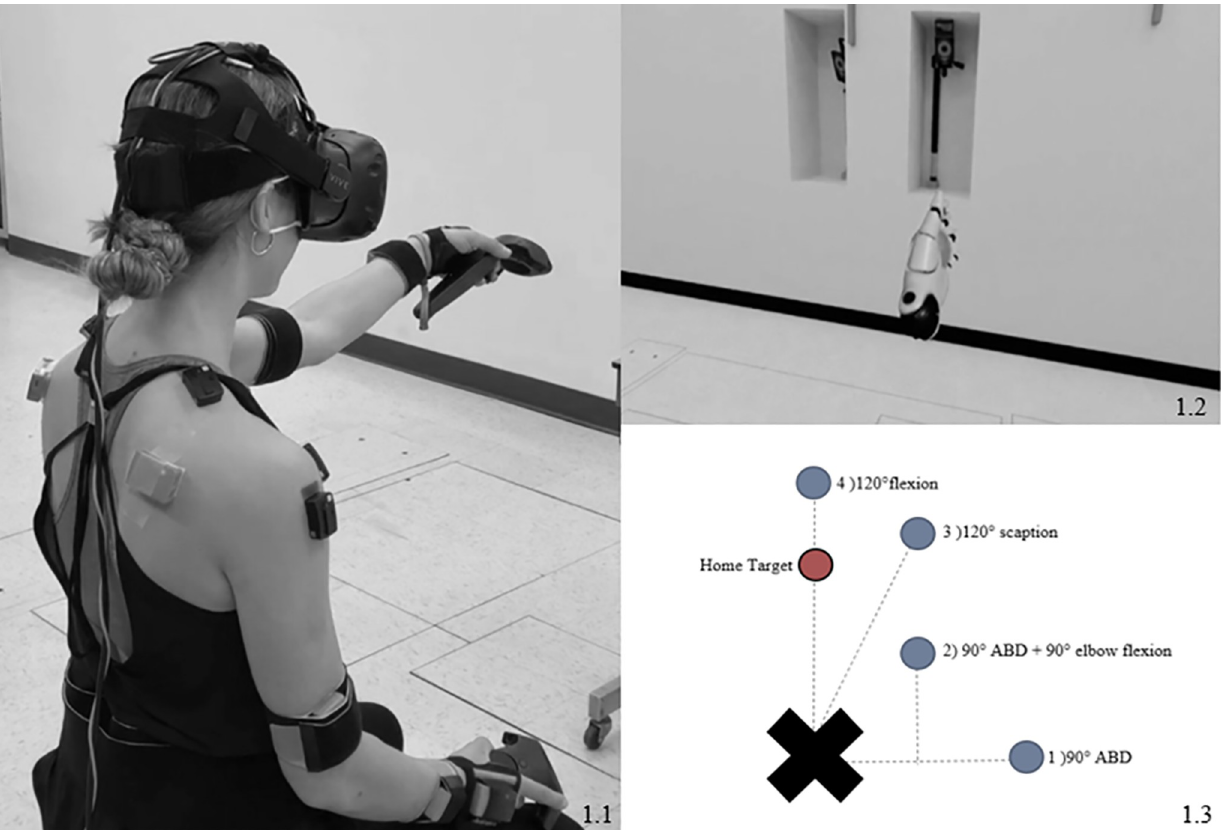
Fig 1. Targets position and set up. ABD: abduction. a: a participant performing the task with EMG sensors, IMUs and VivePro helmet and controllers; b: Participant view of its virtual hand while performing the task, left hand on home target; c: Top view of the positioning of the targets around the participant (right-handed). The Home target is positioned at 90˚ of shoulder flexion; Target 1 at 90˚ of shoulder abduction, elbow fully extended; Target 2 at 90˚ of shoulder abduction and 90˚ of shoulder external rotation, elbow flexed at 90˚, Target at 120˚ of shoulder elevation in the scapular plan and Target 4 at 120˚ of shoulder